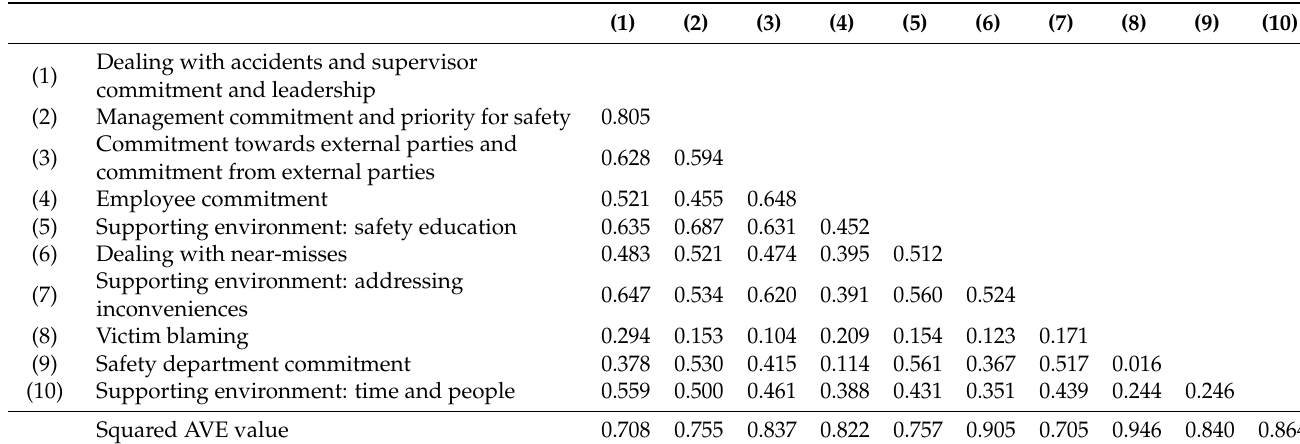
Table 5. Results CFA—Perceptual domain (n = 444)—assessment of discriminant validity (comparison of squared average variance extracted and constructs’ correlations).